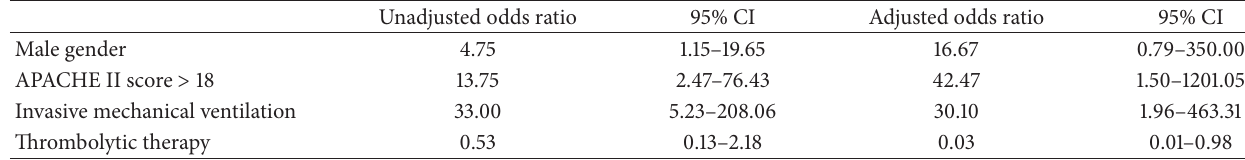
Table 6: Odds ratios for mortality in group